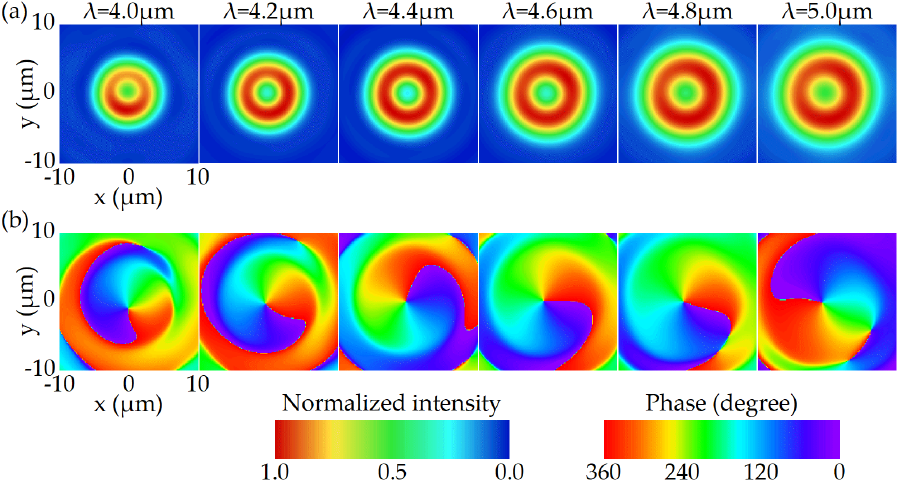
Figure 5. The simulated electric field distribution for the FVBG with zero dispersion on the focal plane between 4.0 and 5.0 μ m. ( a ) Normalized intensity. ( b ) Phase.